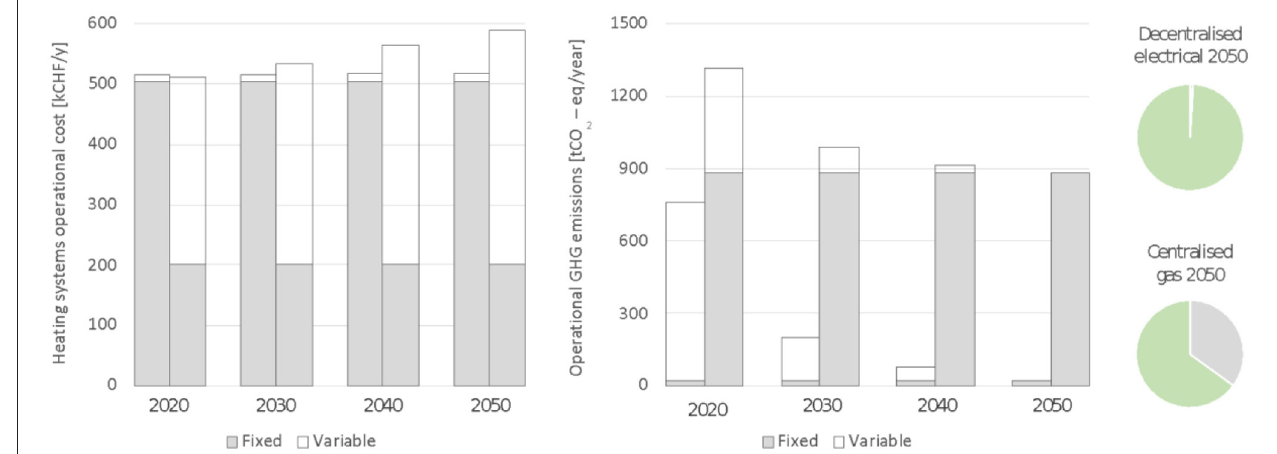
FIGURE 14 | Impact of future trends on the